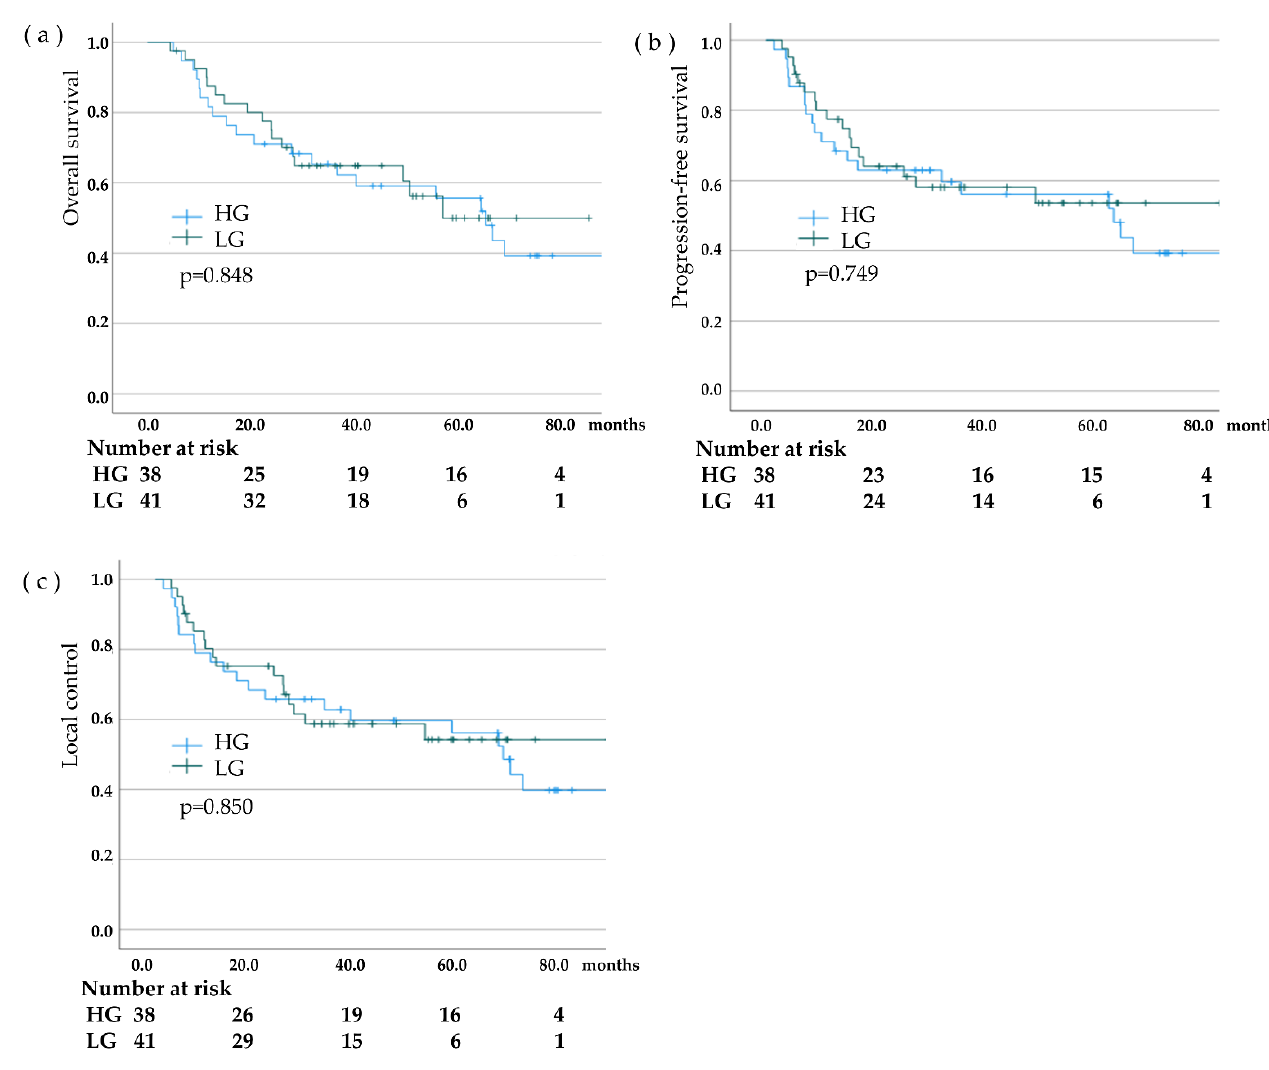
Figure 2. Comparison of the high-dose group (HG) and the low-dose group (LG) in overall survival (OS) rate, progression-free survival (PFS) rate, and local control rates. ( a ); Overall survival (OS) ( b ); Progression-free survival (PFS) ( c ); Local control (LC). Table 3. Changes in patient status with treatment ( n = 79).